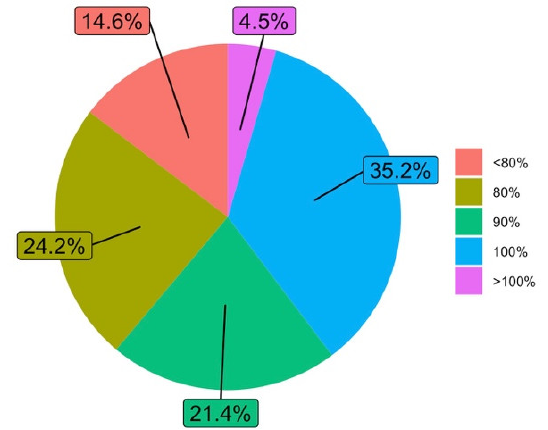
Figure 8. Percentage of the subject that faculty managed to teach with the same depth with respect to previous courses (answers to Q9).